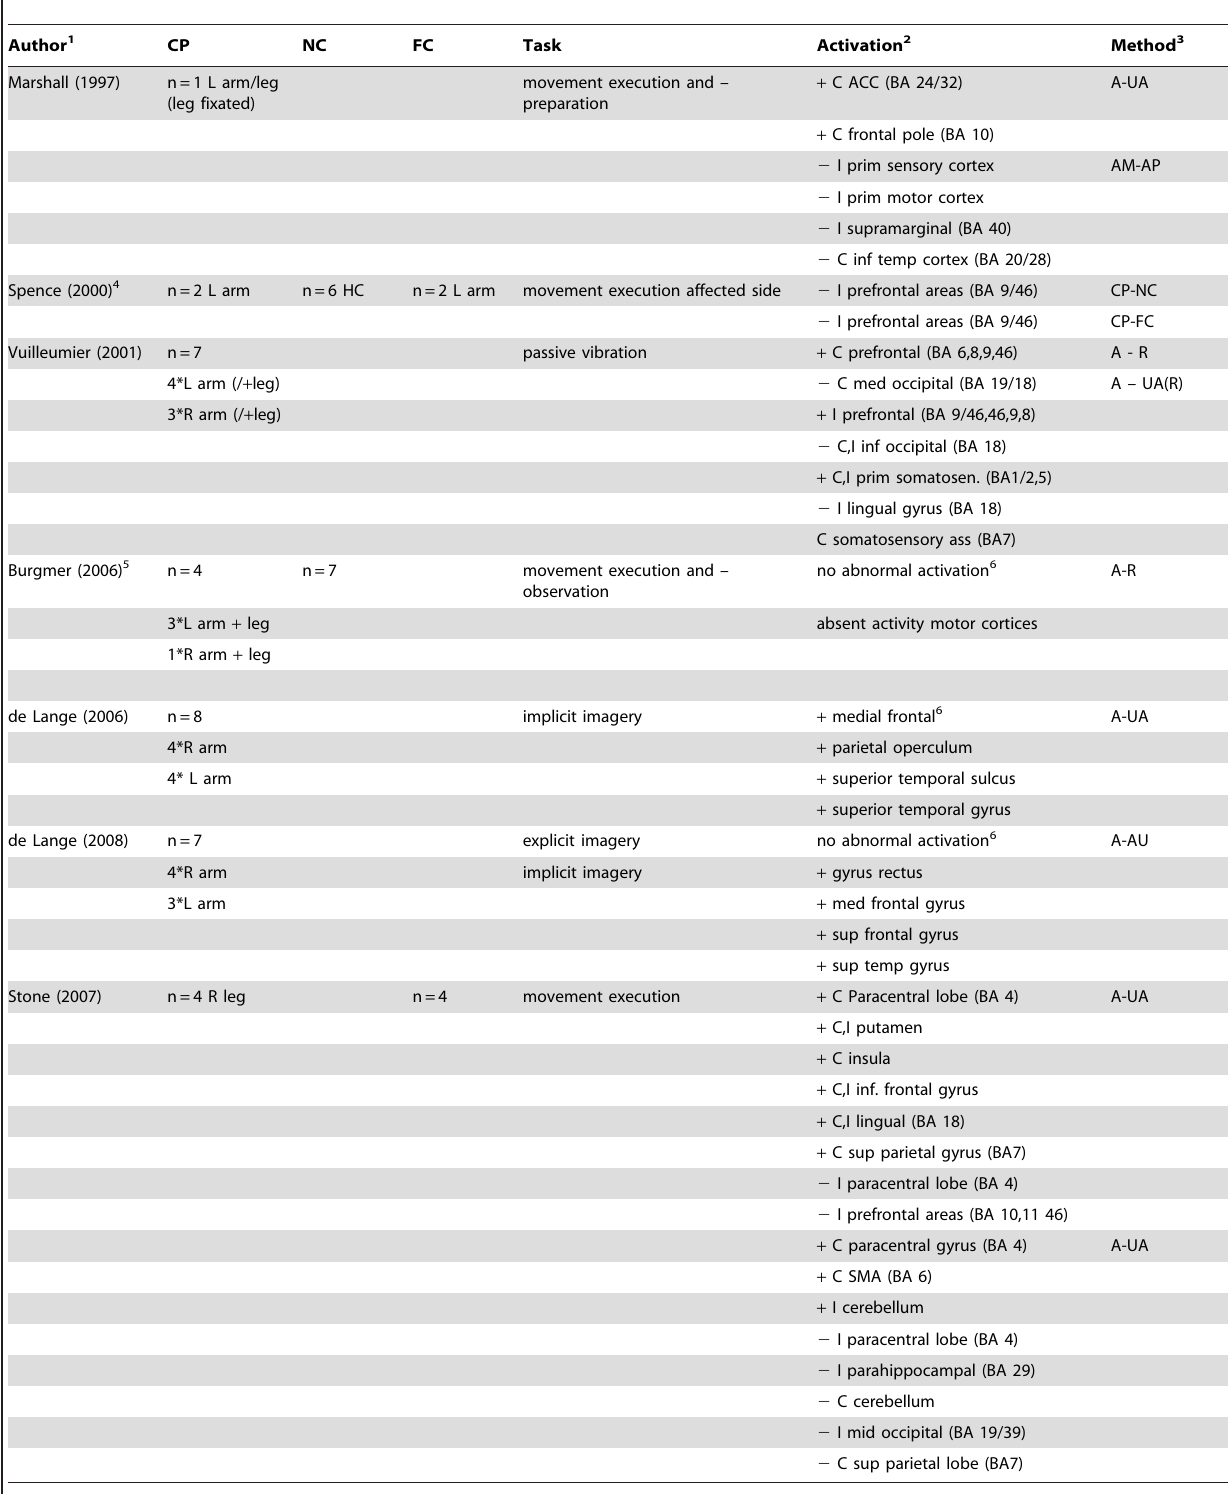
Table 1. Summary of fMRI results of abnormal cortical activation in conversion